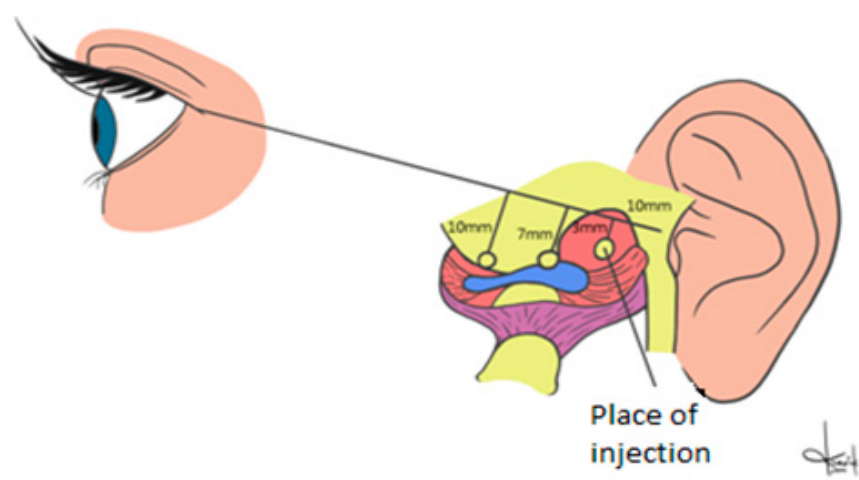
Figure 2. Schema of the placement of the injection point within temporomandibular joint.